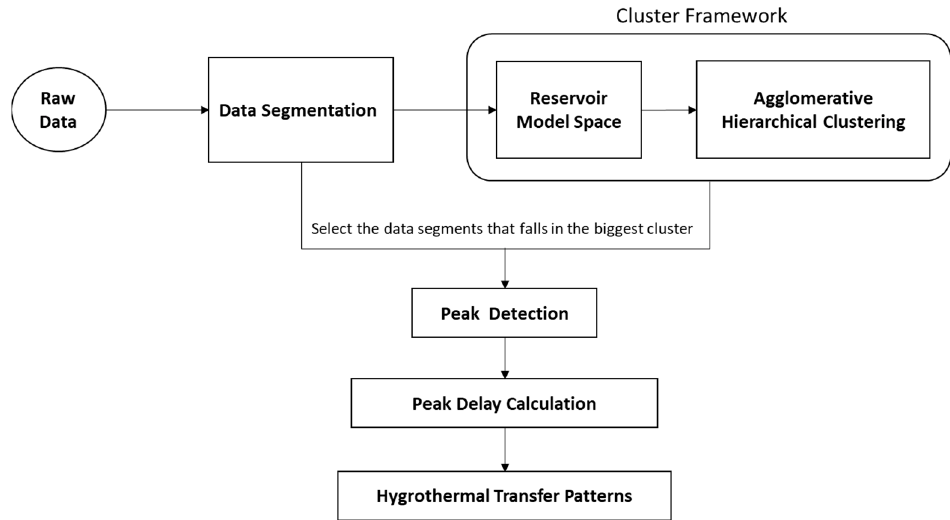
Figure 4. An overview of the research workflow.